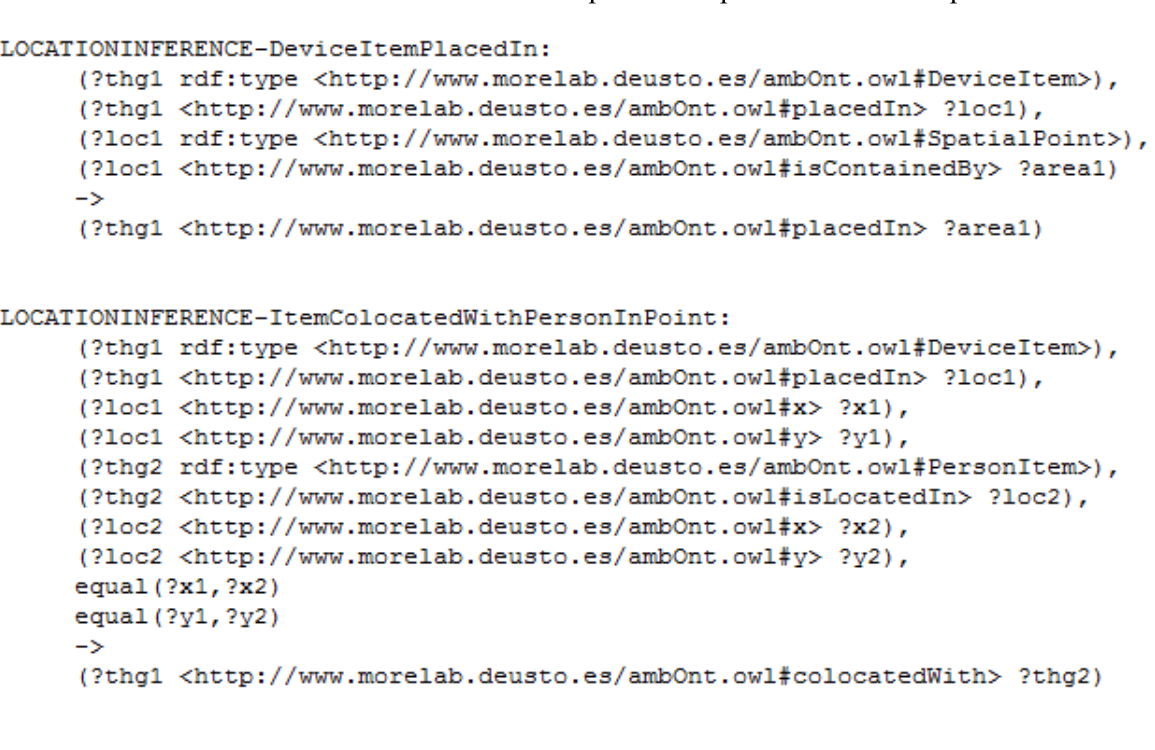
device. The second rule infers if a device and a person are placed in the same